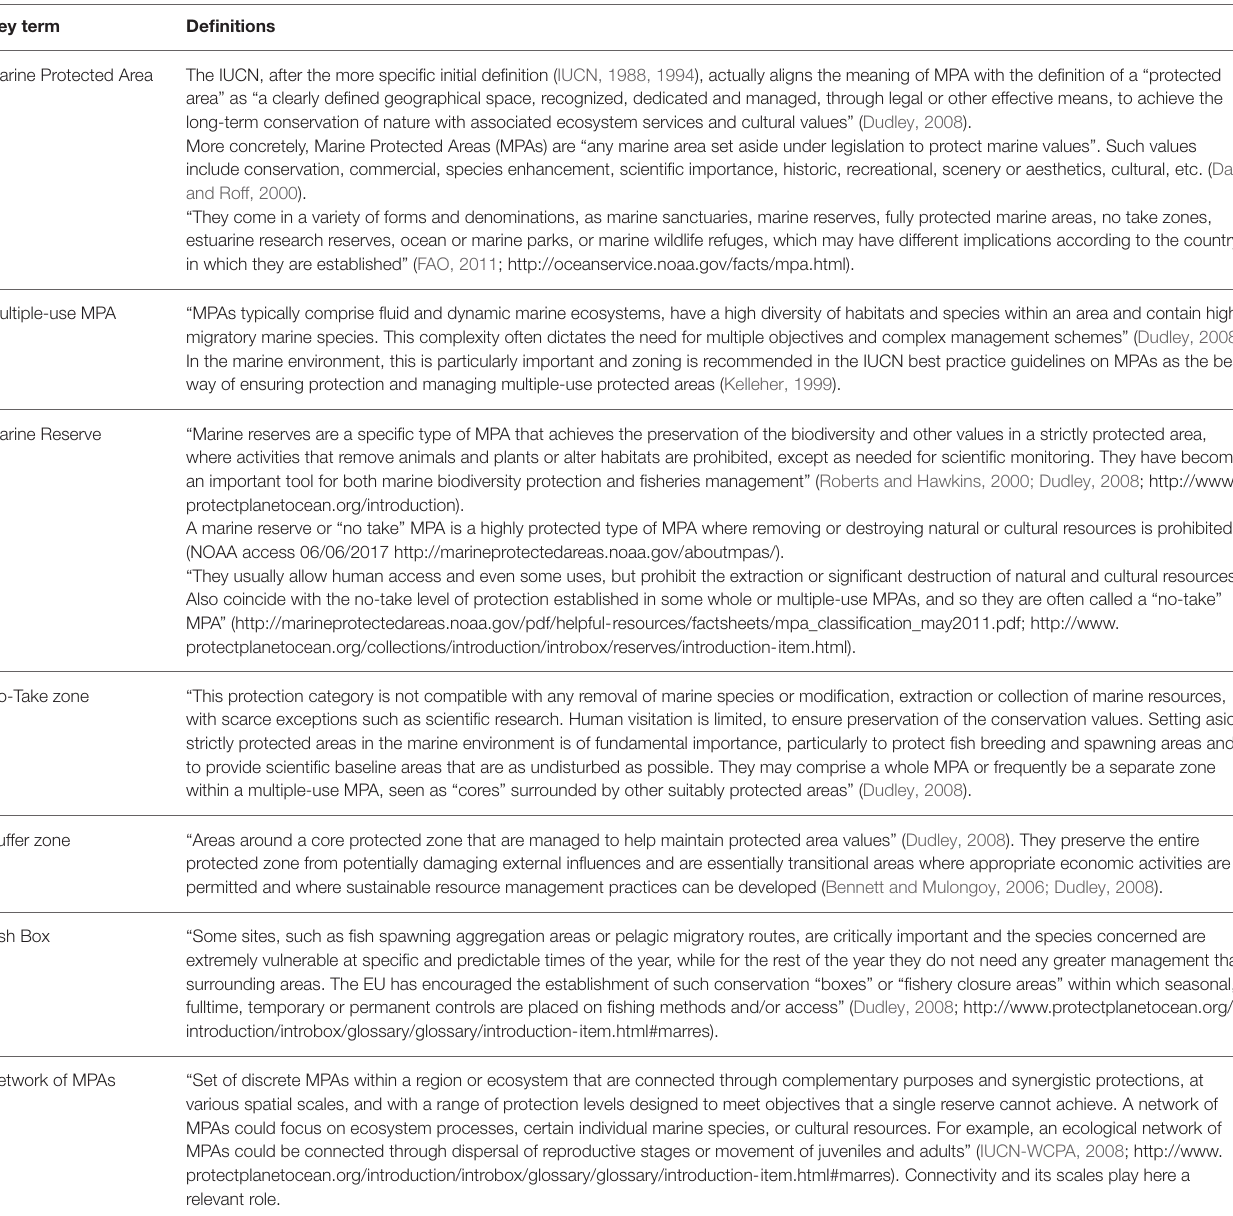
TABLE 1 | Definitions of the most common existing figures and terminology for the protection of marine